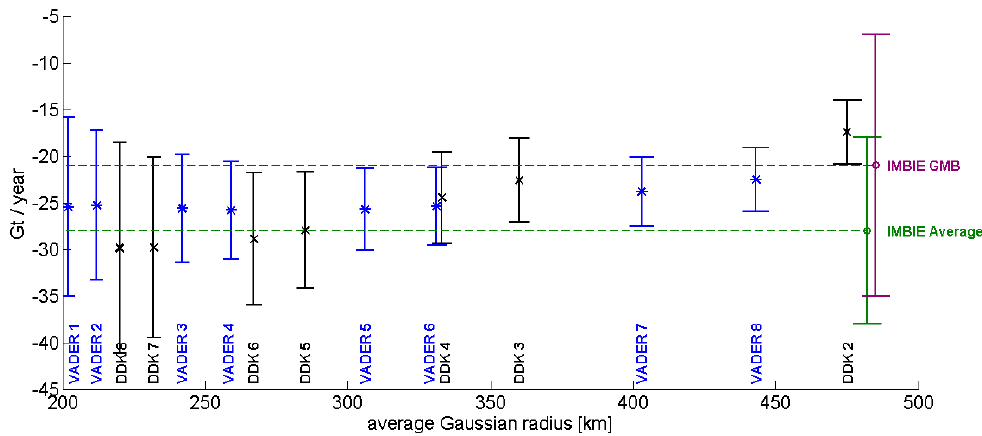
Figure 7. Estimated mass trends applying different DDK (black cross marks) and VADER (blue asterisk marks) filter strengths in Gigatons per year for the region of the Antarctic Peninsula. In purple color the IMBIE mass balance estimate based on the gravity method, in green color the average of all methods applied and compared in [2] are plotted.